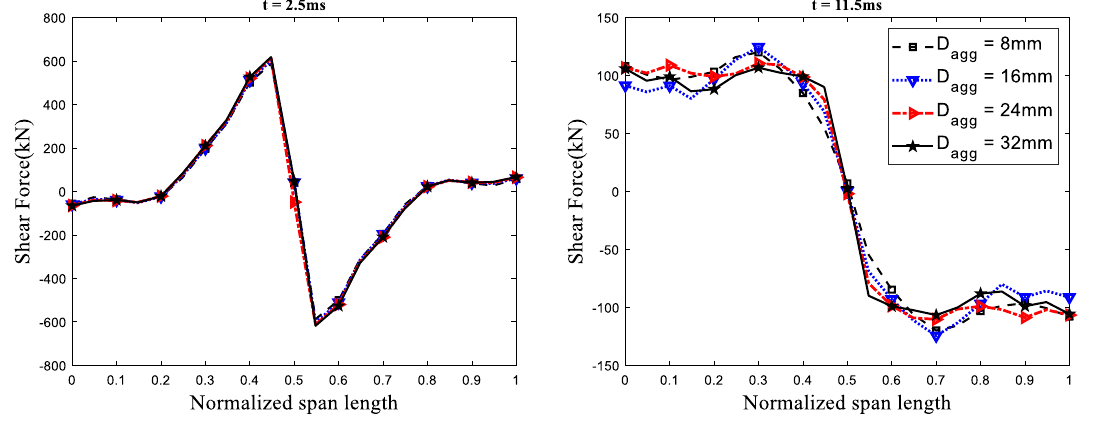
Fig. 21 Shear force diagram for BM1-S at 2.5 ms and 11.5